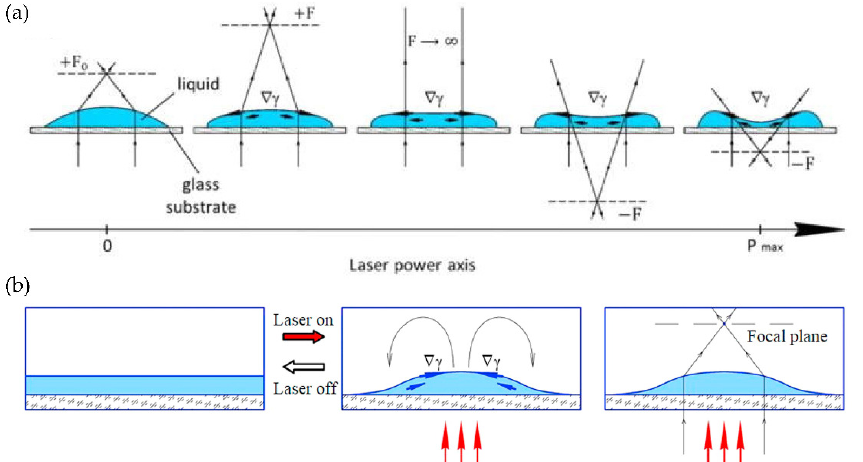
Figure 28. Thermal effect lens actuated by laser-induced: ( a ) Marangoni forces [133], the laser power axis shows the power increase; ( b ) solutocapillary forces [134], schema of the droplet formation process by laser, which contributes to the surface tension gradient. Reprinted with permission from Refs. [133,134]. 2018 AIP Pulishing and 2017